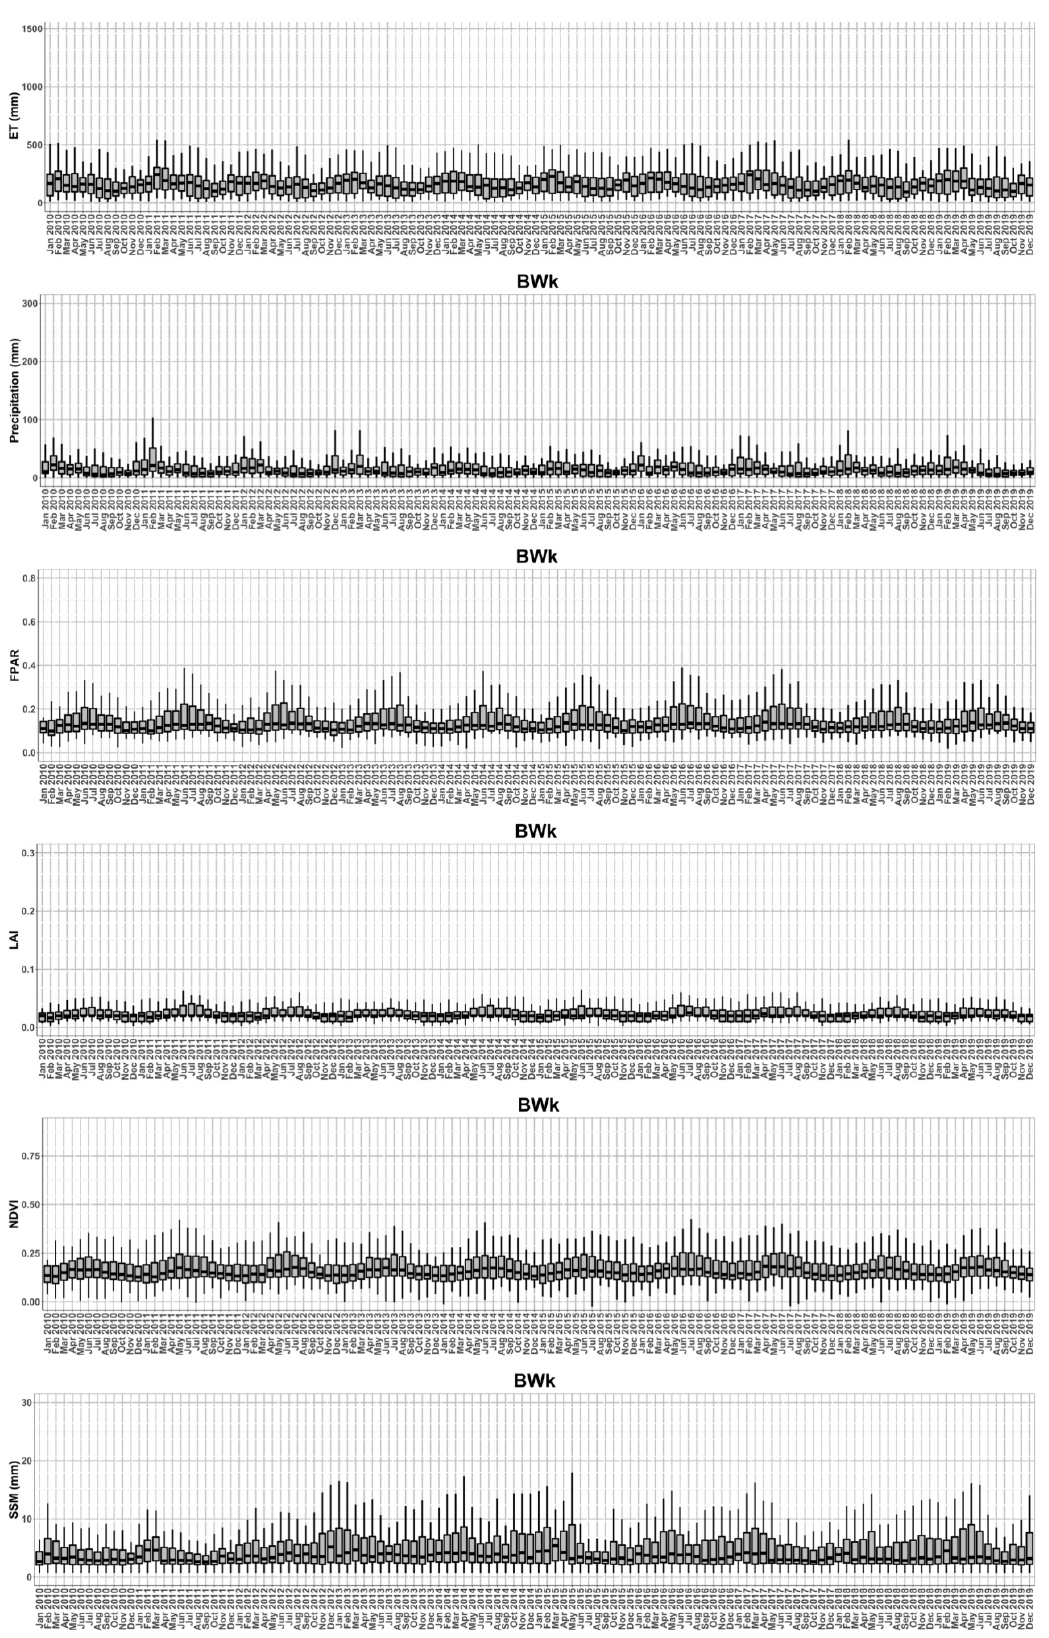
Figure 5. The time series boxplots of ET, precipitation, FPAR, LAI, NDVI and SSM between 2010 and 2019 for BWk.